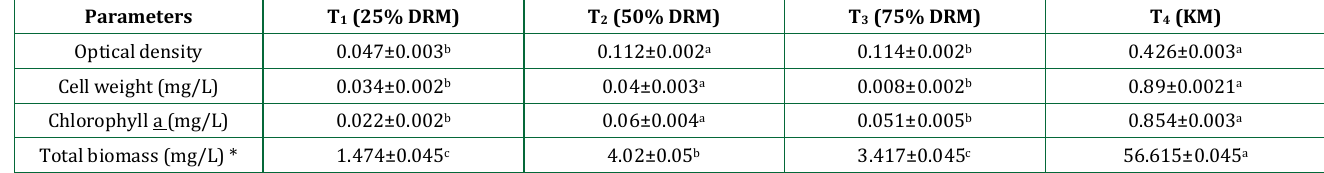
Table 2: Comparison of Optical Density, Cell Weight, Chlorophyll a and Total Biomass of S. Platensis Grown in Supernatant of Different DRMM, and KM on 12 th Day of Culture Before Stationary Phase.